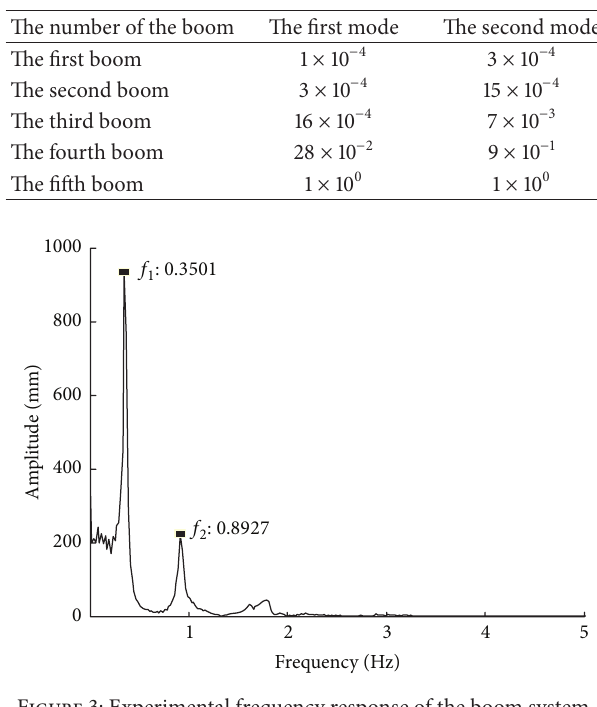
Figure 3: Experimental frequency response of the boom